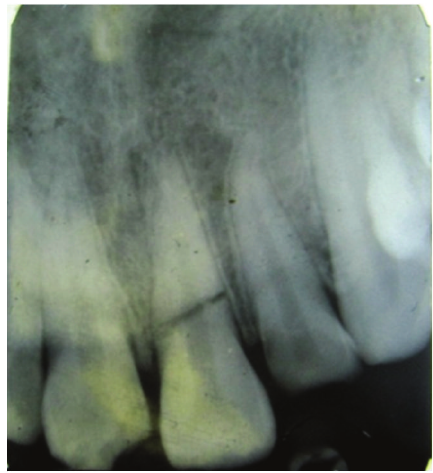
Figure 2: Diagnostic radiograph.